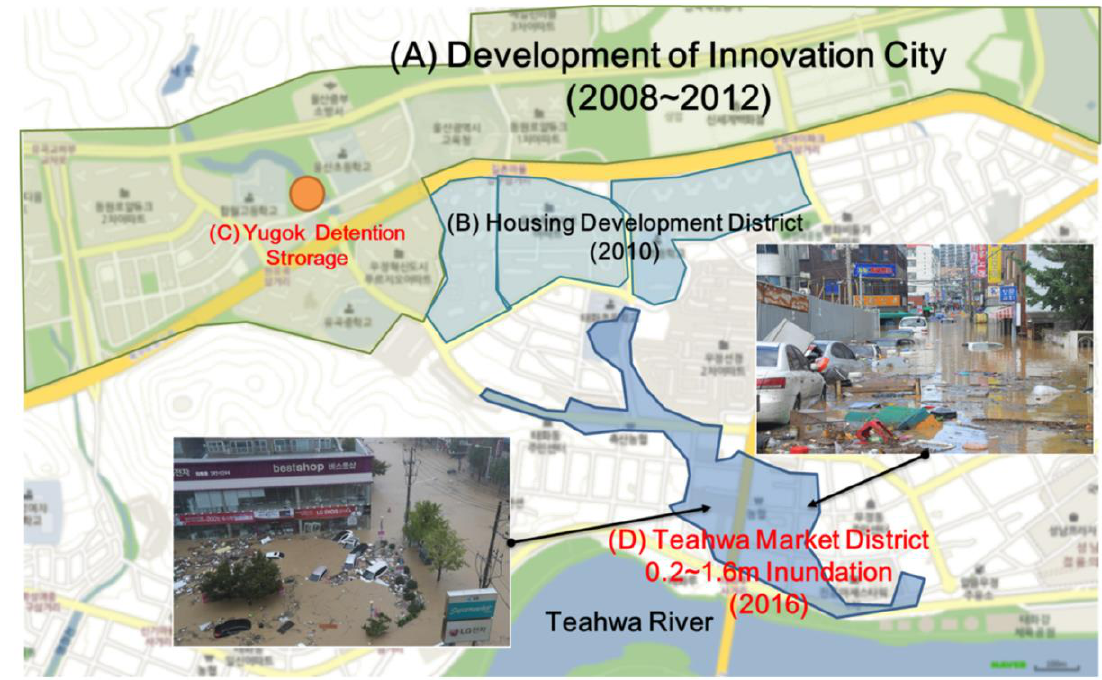
Figure 7. Typhoon “ Chaba ” Inundation Damage and Condition of Business District. Figure 7. Typhoon “Chaba” Inundation Damage and Condition of Business